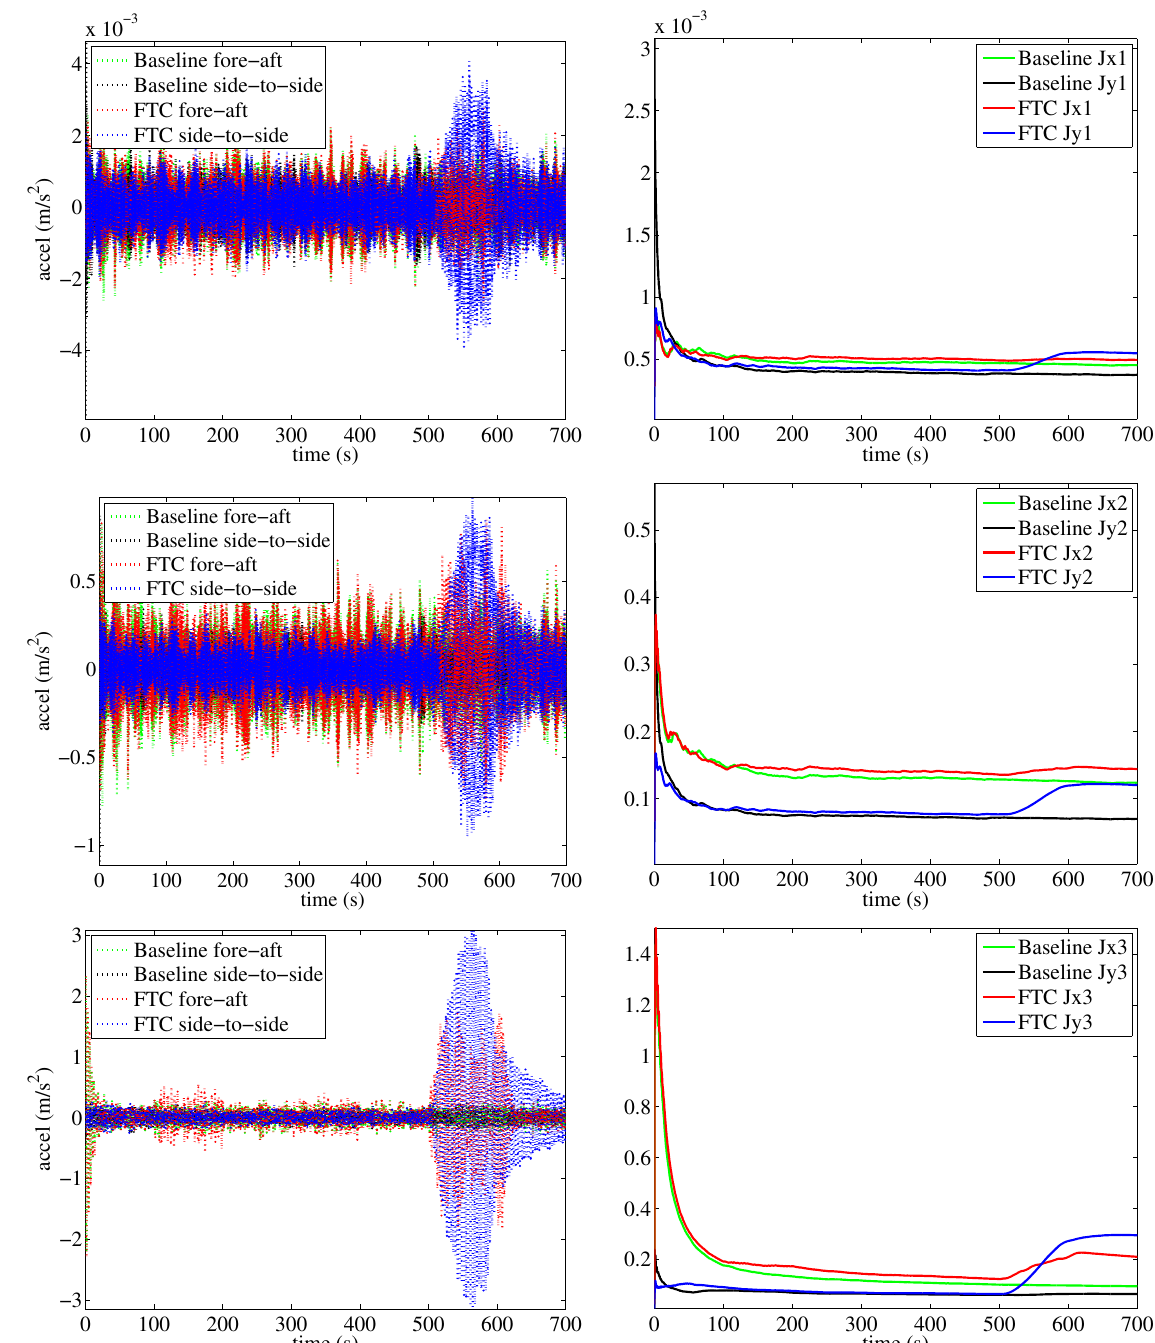
Figure 8. Fore-aft and side-to-side accelerations ( left ) and related indices ( right ) at nodes located at the tower bottom, at mid-tower height and at the tower